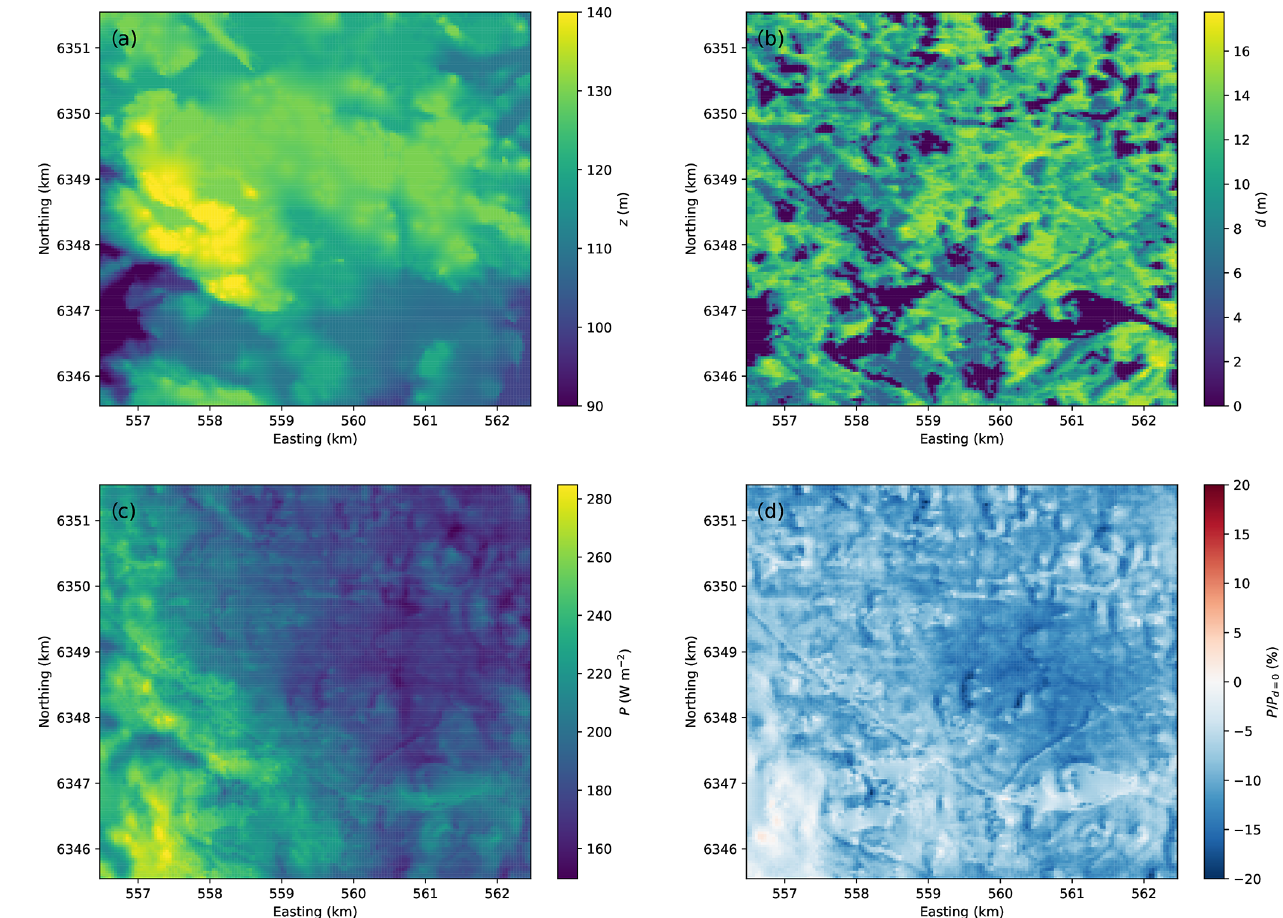
Figure 6. Maps showing the terrain elevation (a) , the displacement height (b) , the power density (c) , and the relative difference in power density compared to a terrain map where d = 0 (d) at Ryningsnäs for westerly winds.